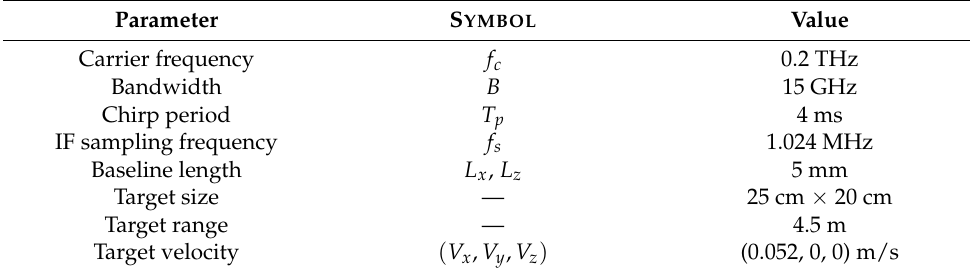
Table 3. Parameters of the system and targets in the experiments.